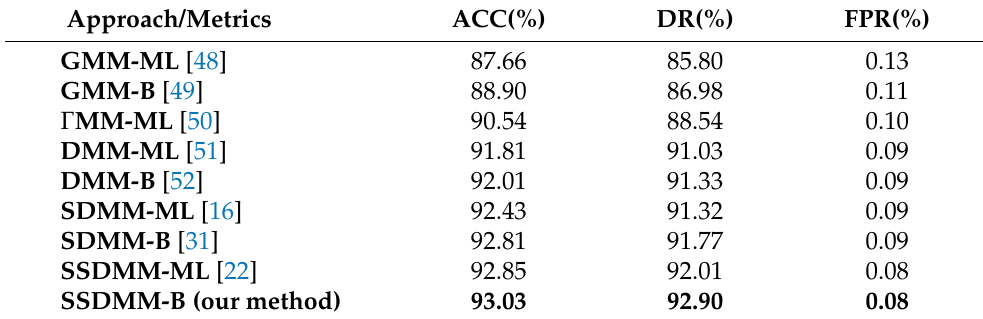
Table 3. Overall accuracy for CXR-Pneumonia Dataset.